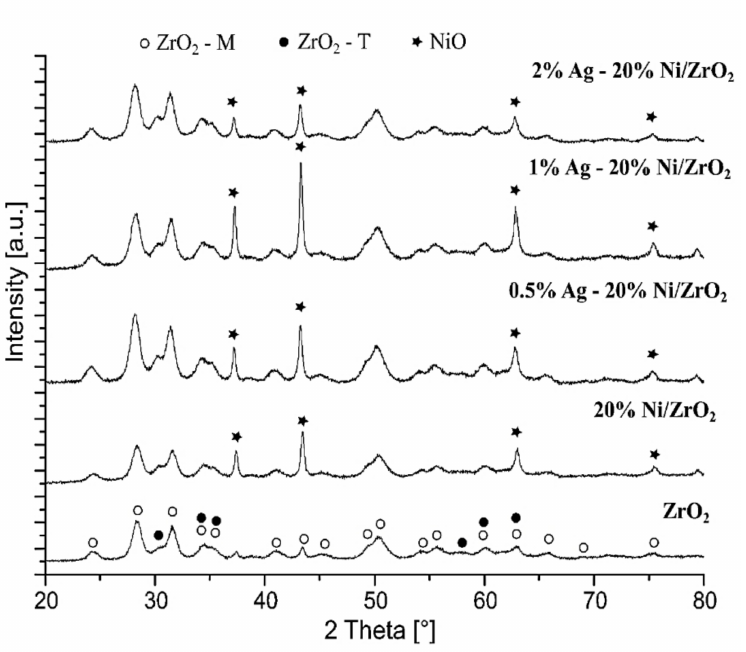
Figure 8. Powder patterns of the support, mono- and bimetallic supported catalysts calcined in an air atmosphere at 400 ◦ C for 4 h.